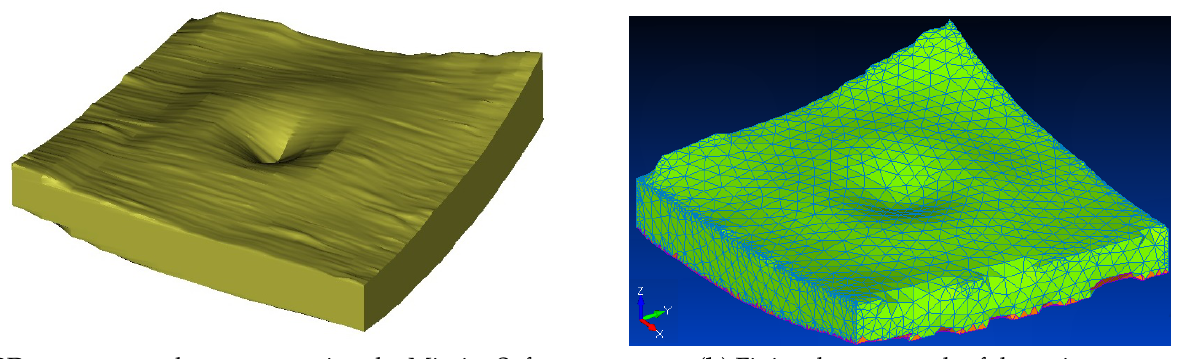
Figure 5. 3D model of the retina and corresponding finite element mesh obtained from the patient 1 healthy